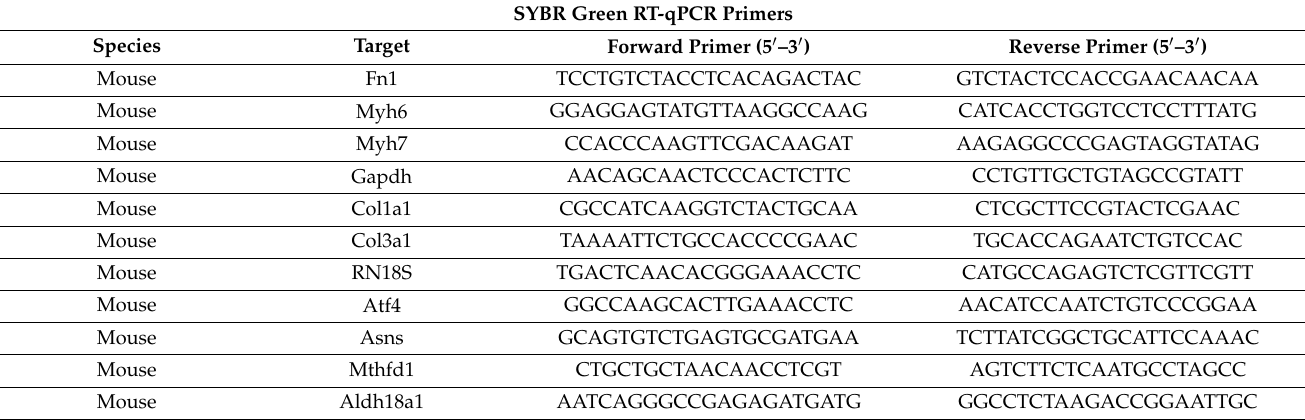
Table 2. qPCR primers used in this study (SYBR